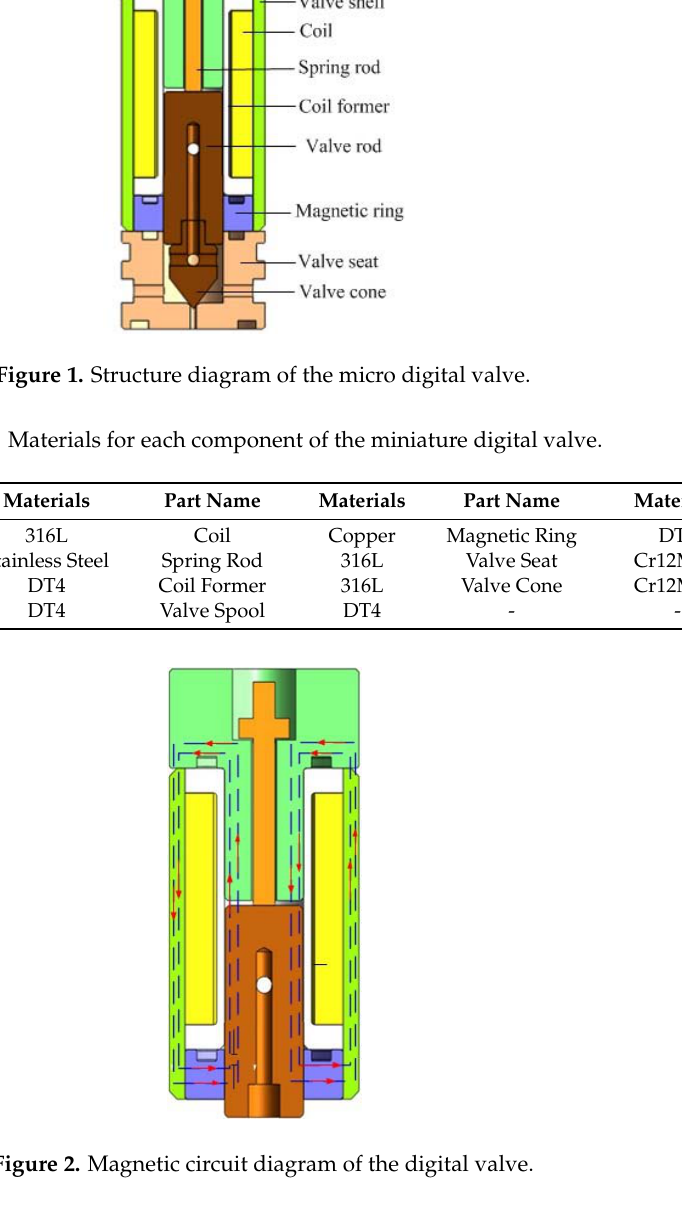
Table 3. Materials for each component of the miniature digital valve.